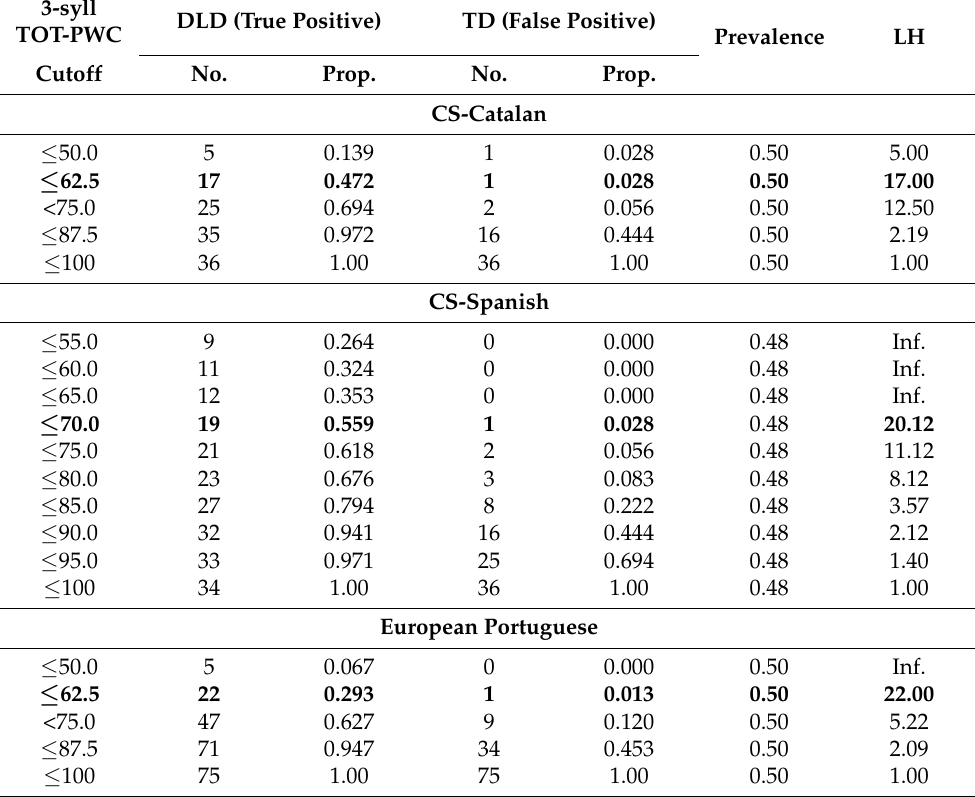
Table 8. The number and proportion of children with a positive test result (ruling in disorder), prevalence and likelihood ratio (LH) for each of the cutoff value based on total word percentage correct (TOT-PWC) for 3-syllable nonwords for the Catalan–Spanish (CS) and European Portuguese (EP) children with developmental language disorder (DLD) and typically developing (TD)